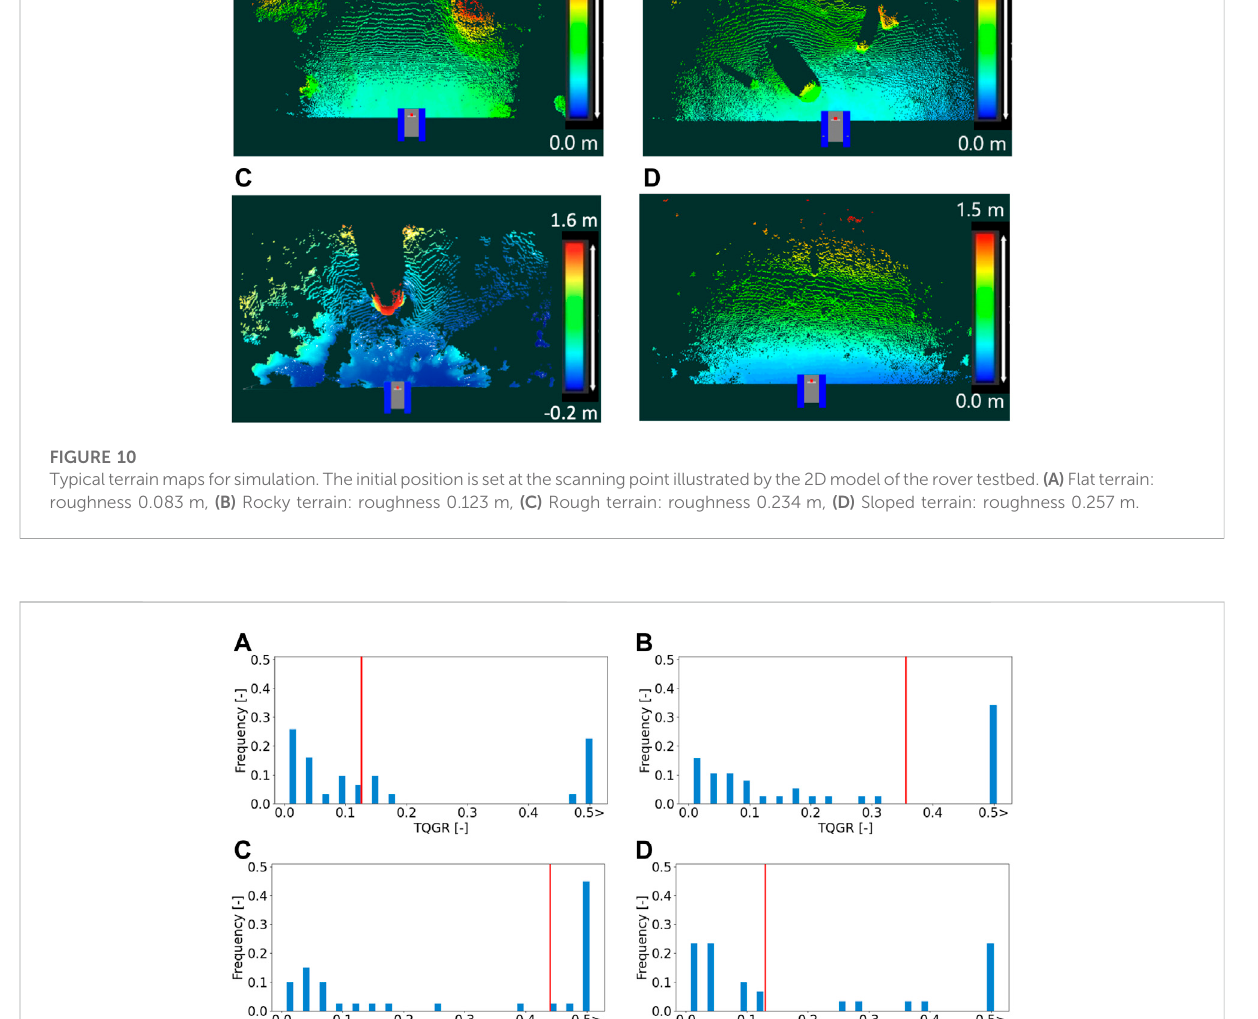
Frontiers in Robotics and